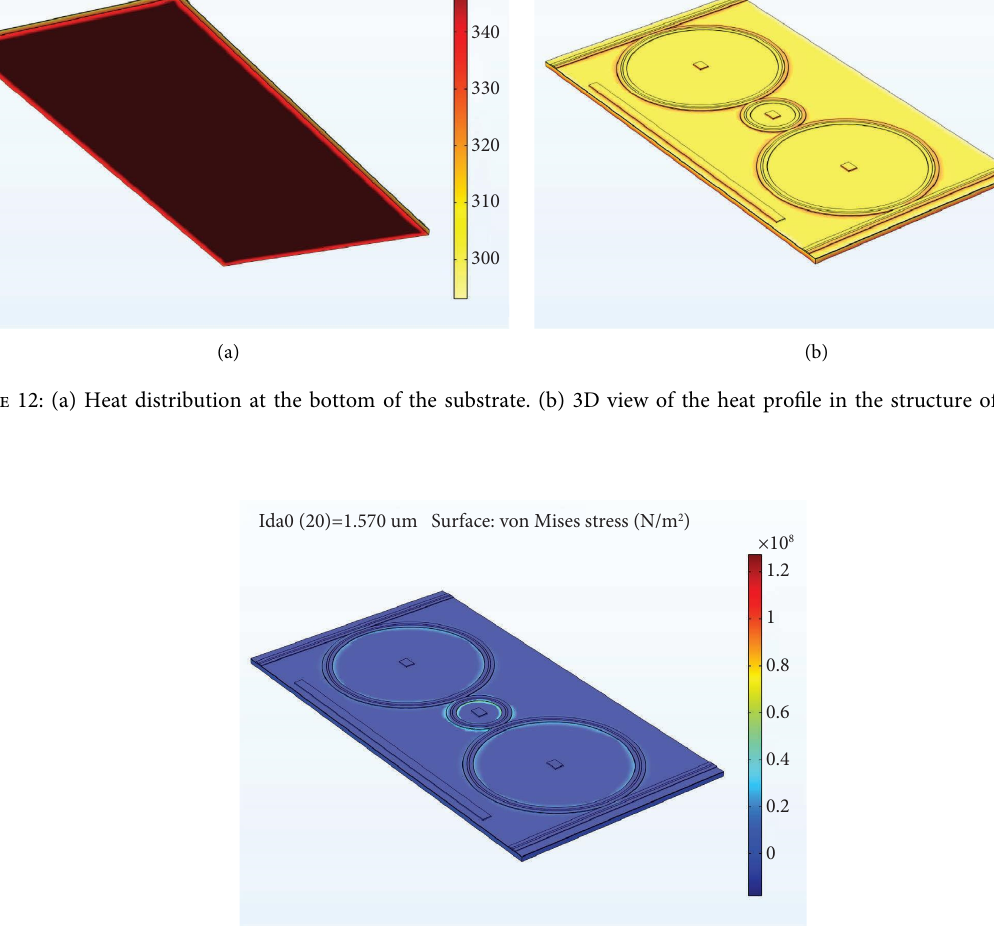
Figure 13: Von Mises stress distribution in the flter due to the heat expansion.